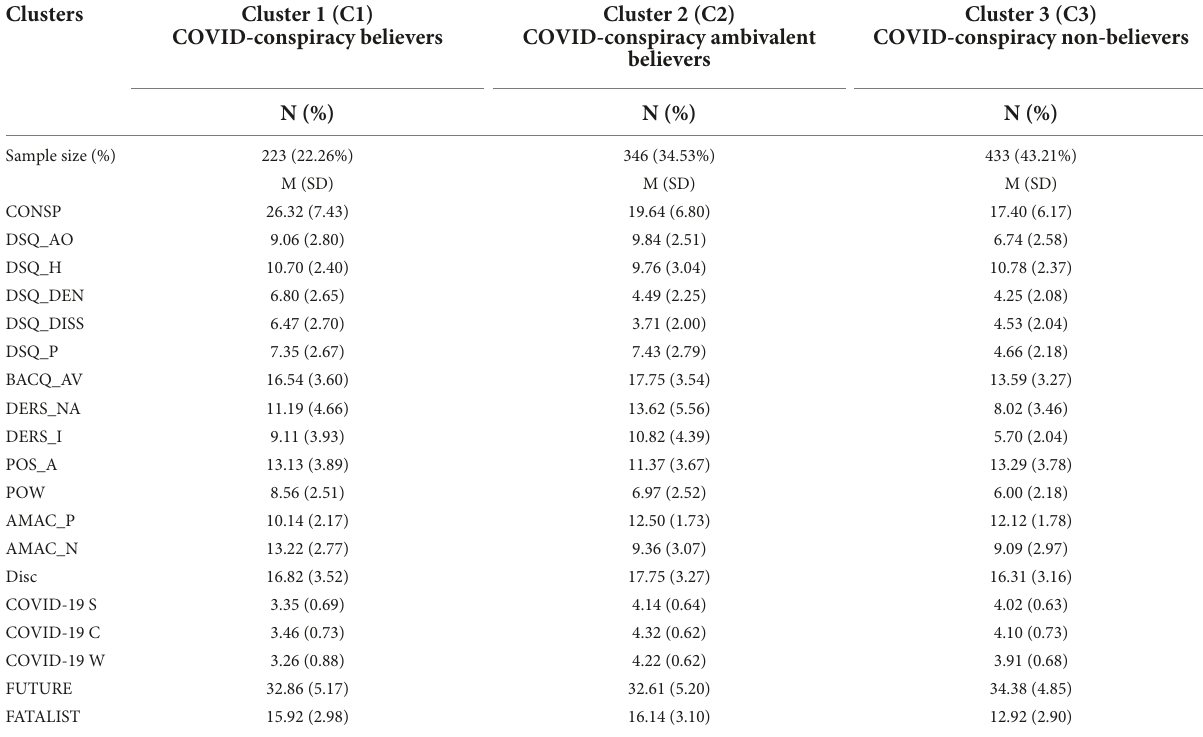
TABLE 4 Sample clusters